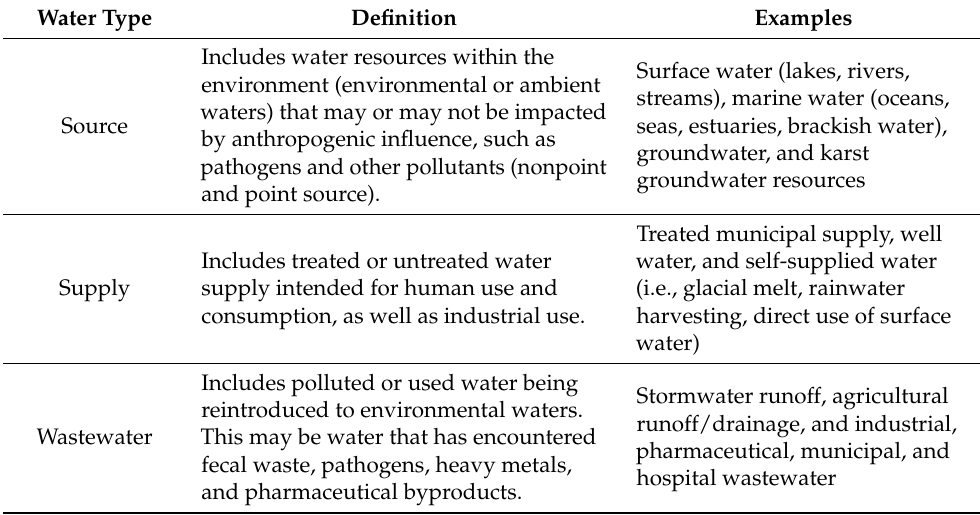
Table 3. Defined water types and examples in relation to antimicrobial